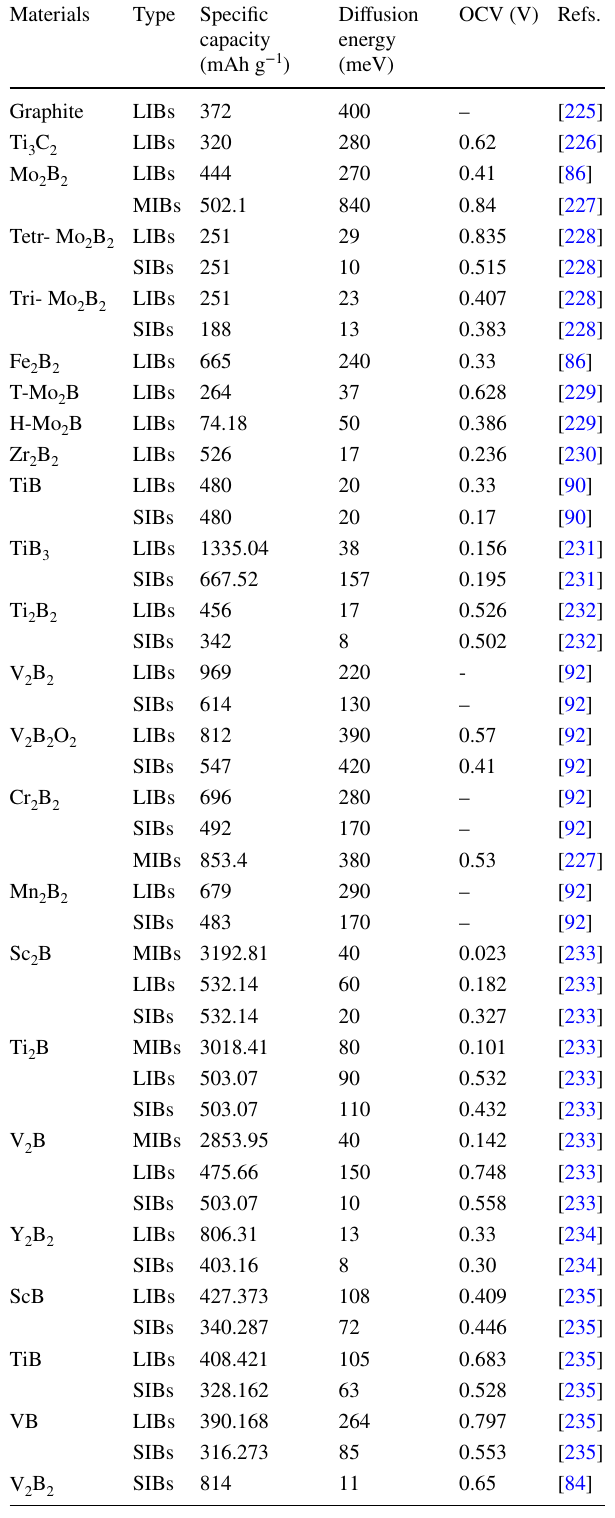
Table 5 Summary of main performances of MBenes as anode mate- rials for rechargeable batteries Materials Type Specific